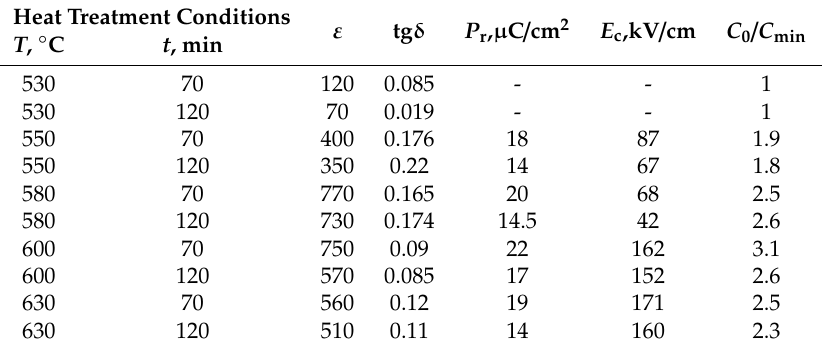
Table 2. Electro-physical parameters of PZT films.